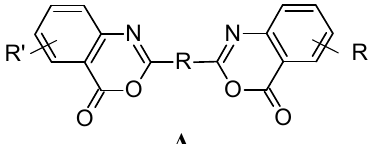
Figure 1. 2,2'-arylene-bis(4 H -3,1-benzoxazin-4-one) derivatives.